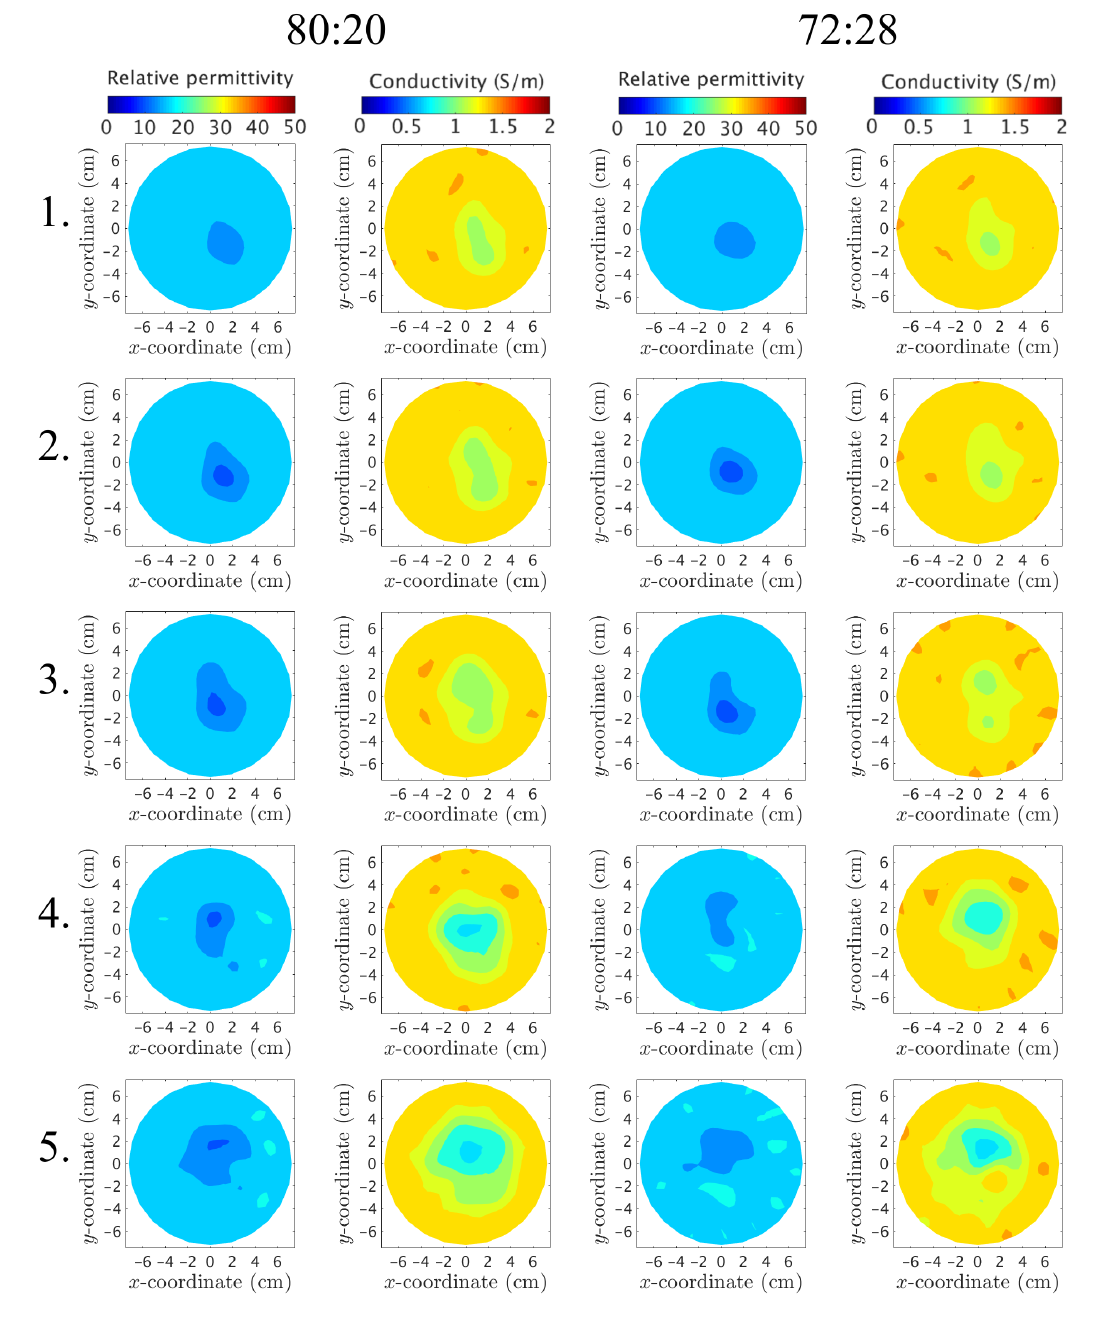
Figure 13. Reconstructed images at 1500MHz of the inner chamber. Each row depicts a layer of the phantom, starting from Layer 1 (closest to the nipple) up to Layer 5 (closest to the chest wall). The columns correspond to (from left to right) the permittivity using the 80:20 mixture, the conductivity for 80:20, the permittivity for 72:28, and the conductivity for 72:28,